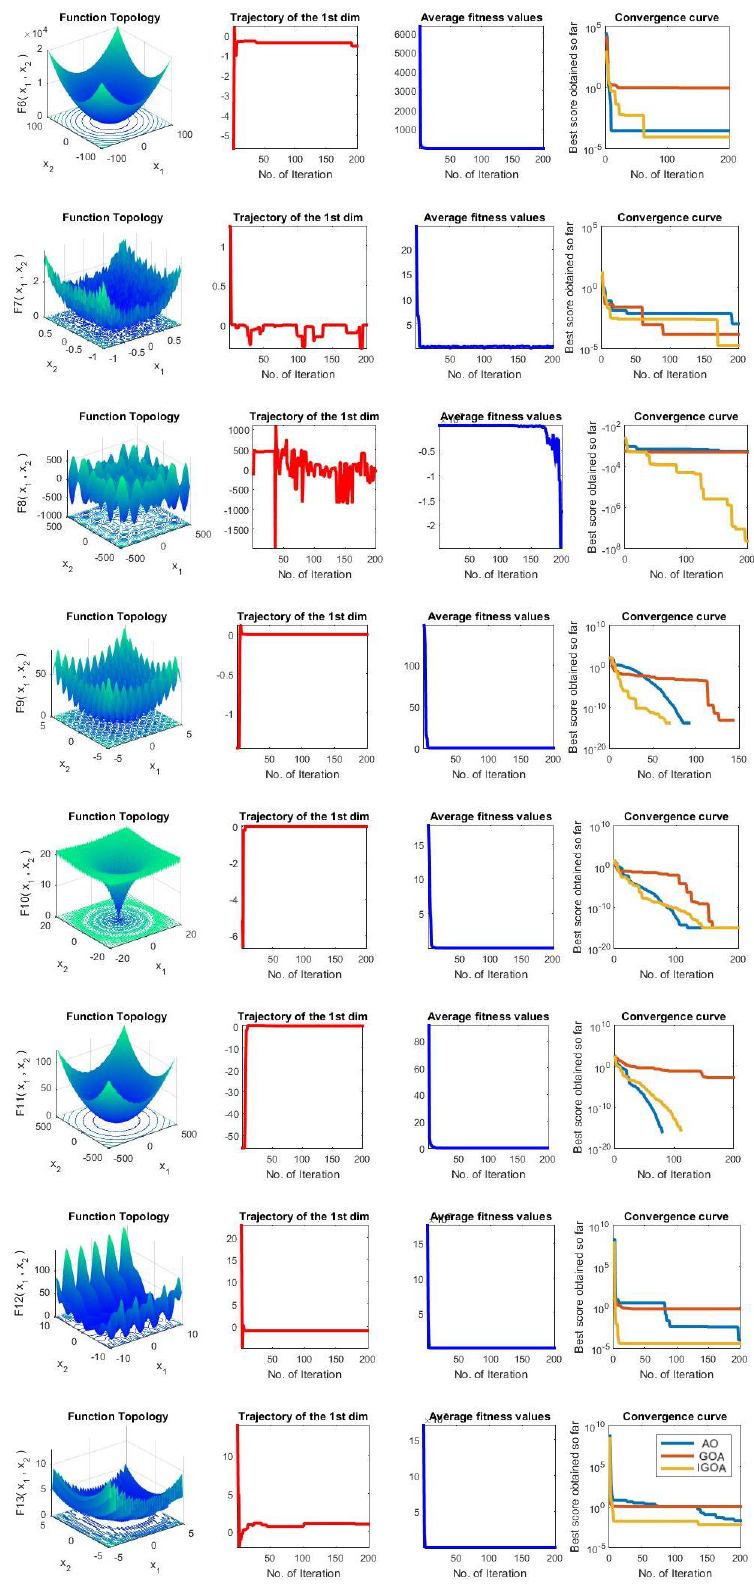
Figure 6. Qualitative results of the proposed